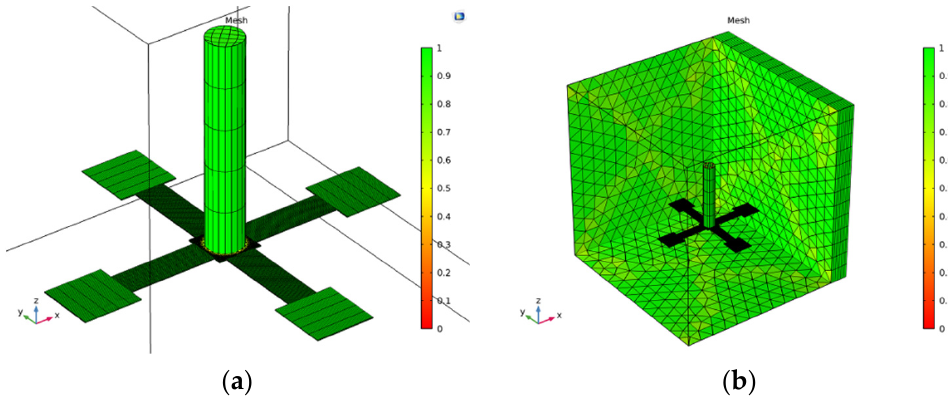
Figure 6. Mesh: ( a ) mesh of crossbeam–cilium; ( b ) overall mesh.